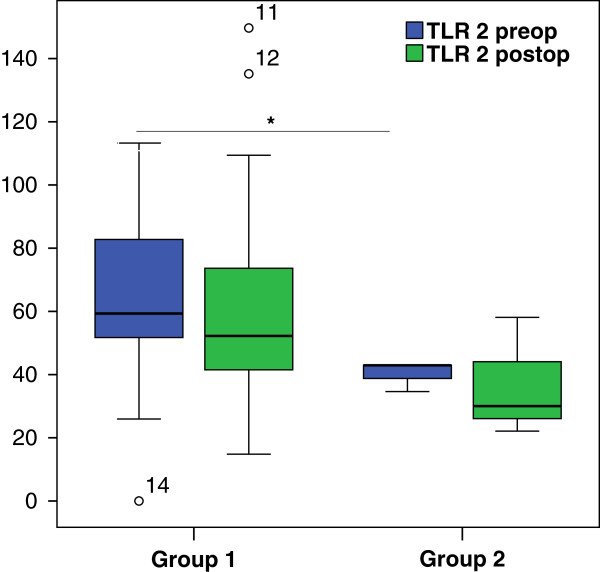
Toll-like receptor (TLR)2 expression on alveolar macrophages (AMs). TLR2 expression in group 1 (n = 29) did not differ before and after surgery (P = 0.32). In group 2 (n = 3) the TLR2 expression was lower by trend after surgery not possible to calculate P value with 3 patients (as in Figure 1 and 3). Comparing both groups, group 2 showed a significantly lower baseline of TLR2 expression (P = 0.027) and a tendency of lower postoperative values (P = 0.21). Box plots represent median and IQR; blue, values before surgery; green, values after surgery. The Wilcoxon test was used for dependent groups and the Mann–Whitney U-Test for independent groups; *P <0.05.